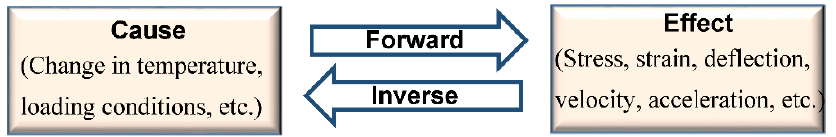
Figure 1. Forward and inverse problems.